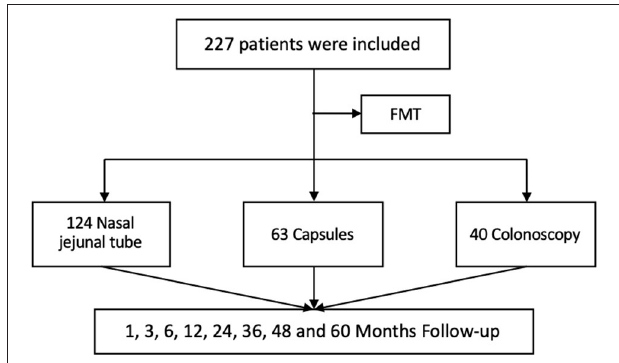
FIGURE 1 | Flowchart of patient inclusion. FMT, fecal microbiota transplantation.